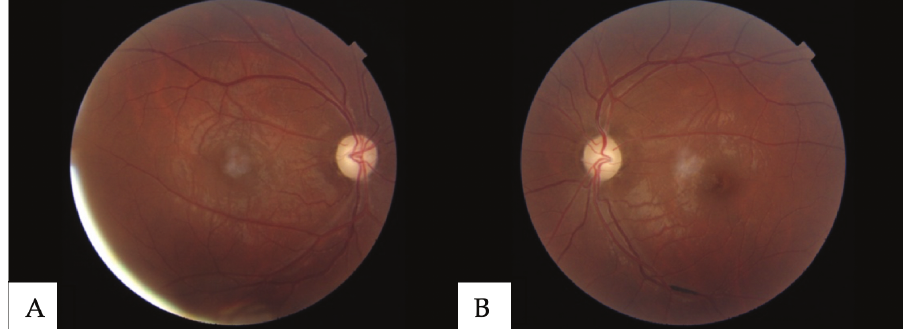
Figure 3. Fundus images of Leber hereditary optic neuropathy. Fundus photographs of a patient with Leber hereditary optic